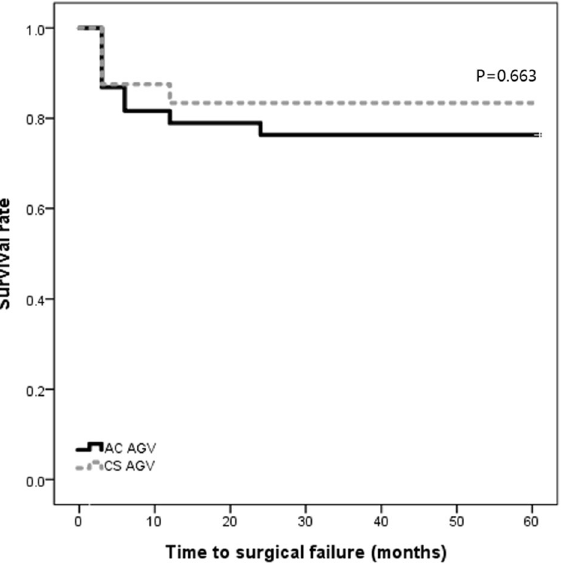
Figure 1. Kaplan–Meier survival curves after ciliary sulcus and anterior chamber Ahmed glaucoma valve implantation. The success rates were 83.3% and 78.9% at 12 months, and 83.3% and 76.3% at 24 months in the ciliary sulcus and anterior chamber groups, respectively. The difference between the survival curves of the two groups was not statistically significant ( p = 0.663 by Log-rank